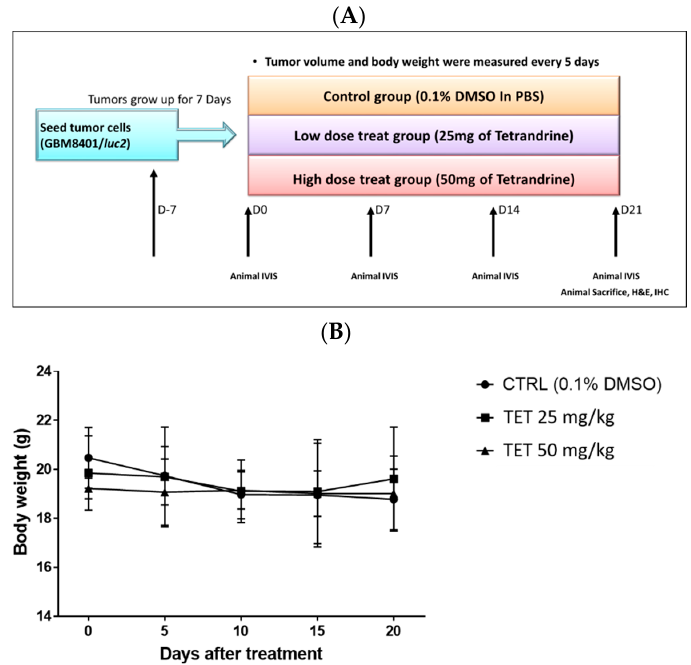
Figure 2. The flow chart and body weight investigation of TET-treated animal experiment in xenografted GBM 8401/ luc2 -cell-bearing animals. An animal experiment flow chart was displayed ( A ), and the body weights of mice from each group were measured every five days ( B ). (25 mg/kg) in the examined animals.